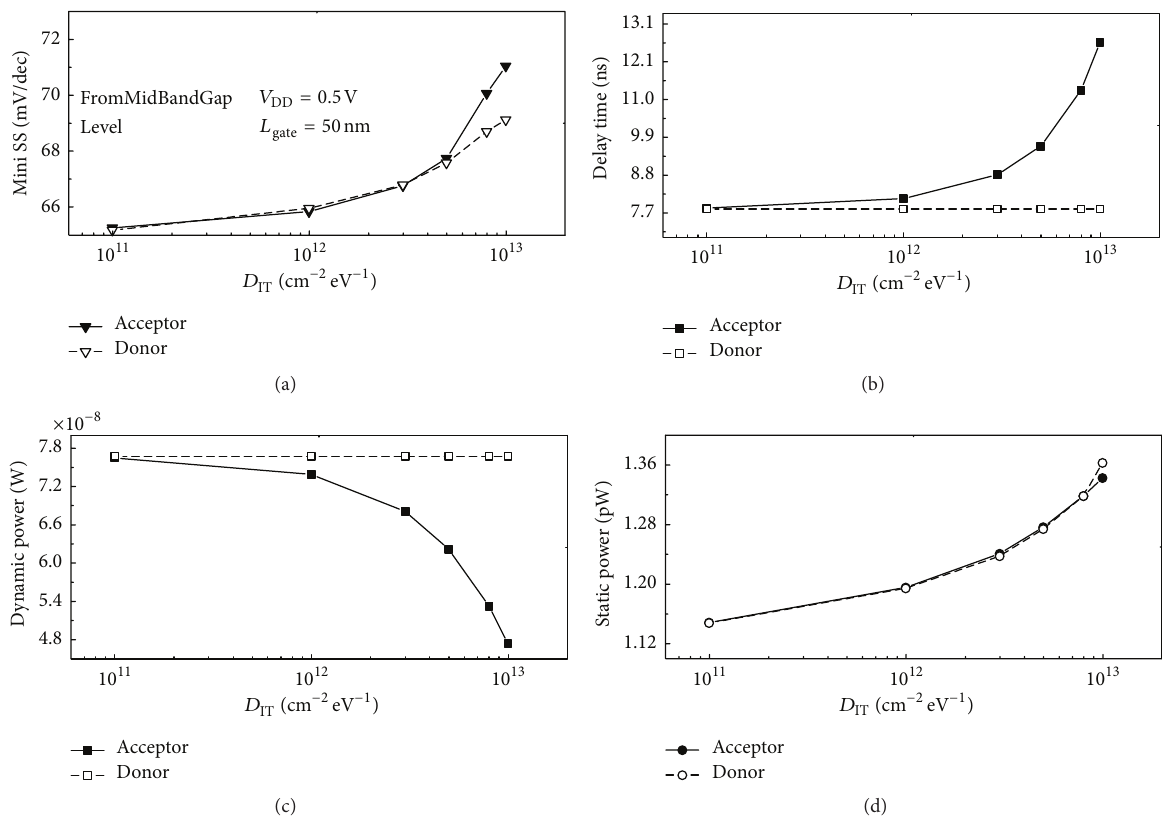
Figure 14: (a) The calculated mini SS, (b) delay time, (c) dynamic power, and (d) static power versus ITs density at valence band. Delay time 𝑉 /𝐼 𝜏 is given by 𝐶 . The acceptor and acceptor-type ITs are essentially the same effect at midgap band and valence 𝐿 DD on